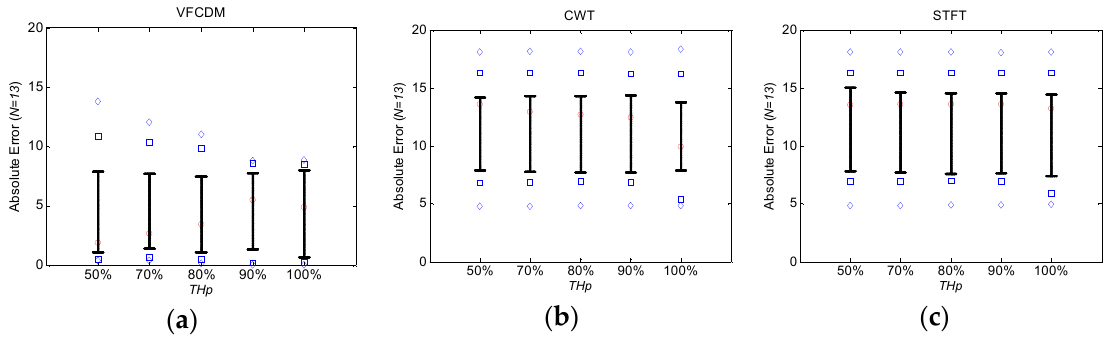
Figure 4. Absolute error distribution of FEV 1 /FVC from healthy subjects according to TH P based on ( a ) VFCDM; ( b ) CWT; and ( c ) STFT.